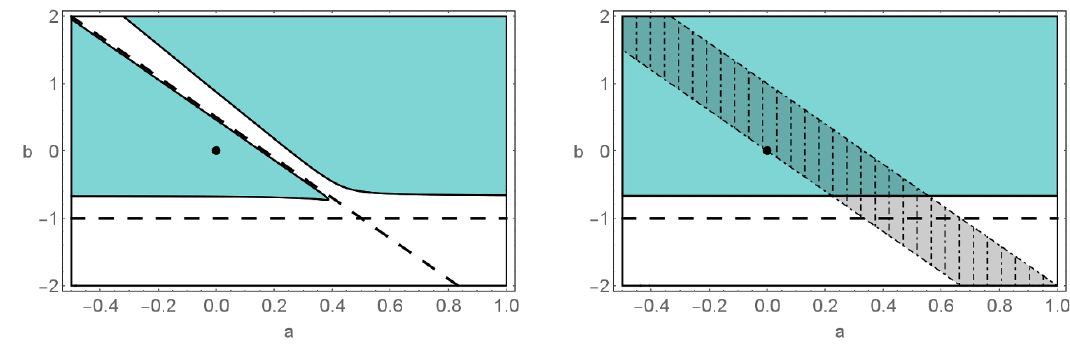
Figure 9 . We show the region where (cid:17) (cid:30) j grav > 0 in cyan as a function of the higher-derivative couplings a and b . The left panel shows the full result, whereas the right panel shows the TT-